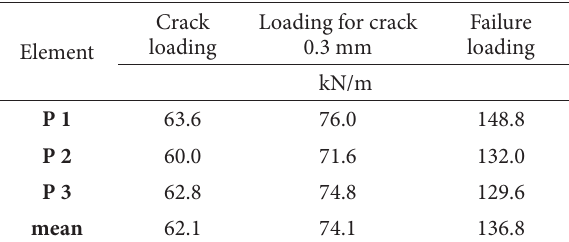
Table 1. Results of the experimental test of three pipes Element